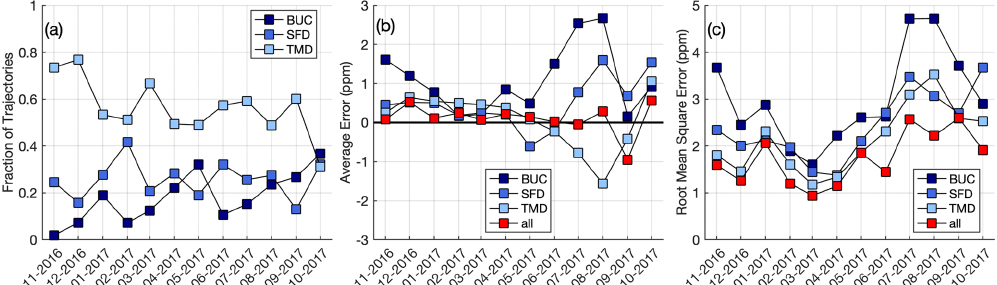
Figure 5. Results from synthetic experiment. (a) Fraction of STILT particle trajectories exiting closest to each background tower by month (MM-YYYY). (b) Bias and (c) RMSE for column-based upwind backgrounds (relative to the true background) in the synthetic data experi- ment using only a single background site (shades of blue), compared with the ideal scenario of all three background towers having available observations (red). Average values over the six urban sites for each month are